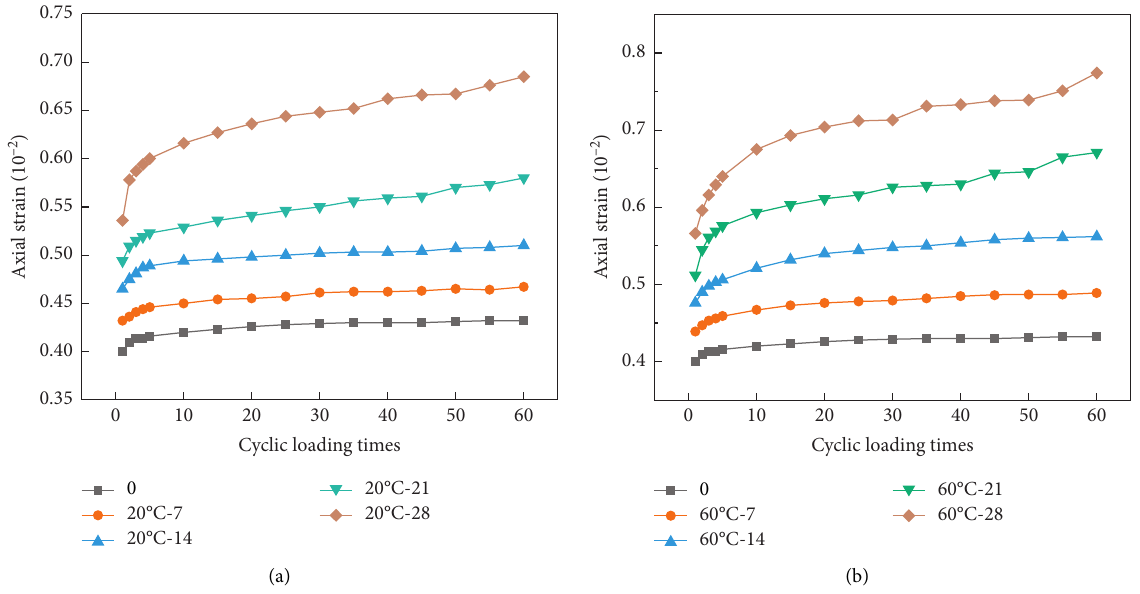
Figure 6: Relationships between loading strain and number of loading cycles: (a) 20 ° C; (b) 60 °